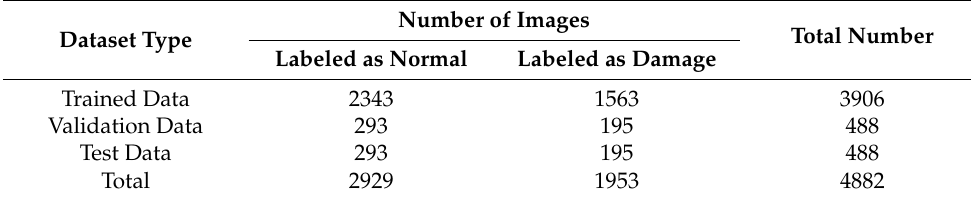
Figure 6. Labeled images with two classes: normal and damaged. Table 4. Dataset type.